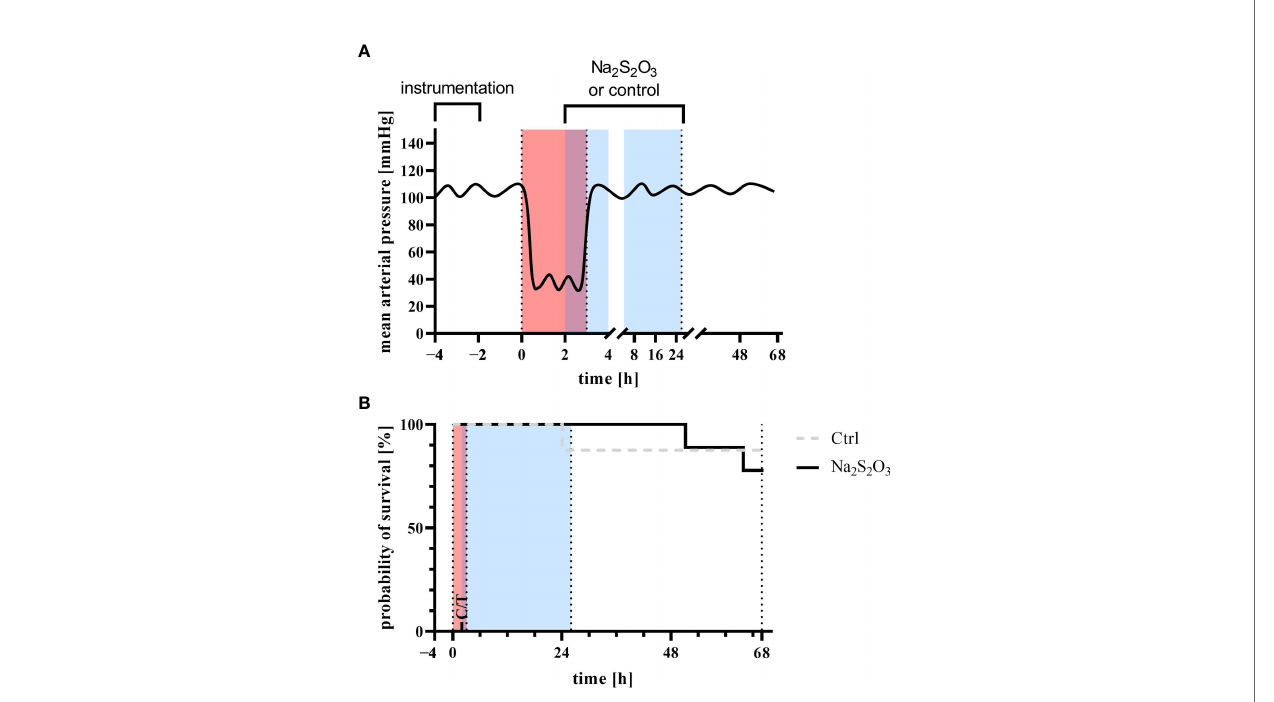
FIGURE 1 | (A) Experimental setup and (B) survival analysis Log-rank Kaplan-Meyer survival analysis of animals receiving sodium thiosulfate (Na 2 S 2 O 3 , n = 9) or vehicle control (Ctrl, n = 8) for the experiment (p = 0.66, Mantel-Cox test). Red indicates the phase of hemorrhagic shock, blue indicates the phase of treatment with Na 2 S 2 O 3 (STS, 0.025 g/kg/h for two hours followed by 0.1 g/kg/h for 23 h) or vehicle control. Instrumentation and resting period was during − 4 h and 0 h, hemorrhagic shock with a target mean arterial pressure of 40 ± 5 mmHg during 0 h and 3 h (red), treatment with sodium thiosulfate or vehicle control during 2 h and 25 h (blue) with a total duration of observation and intensive care therapy of 68